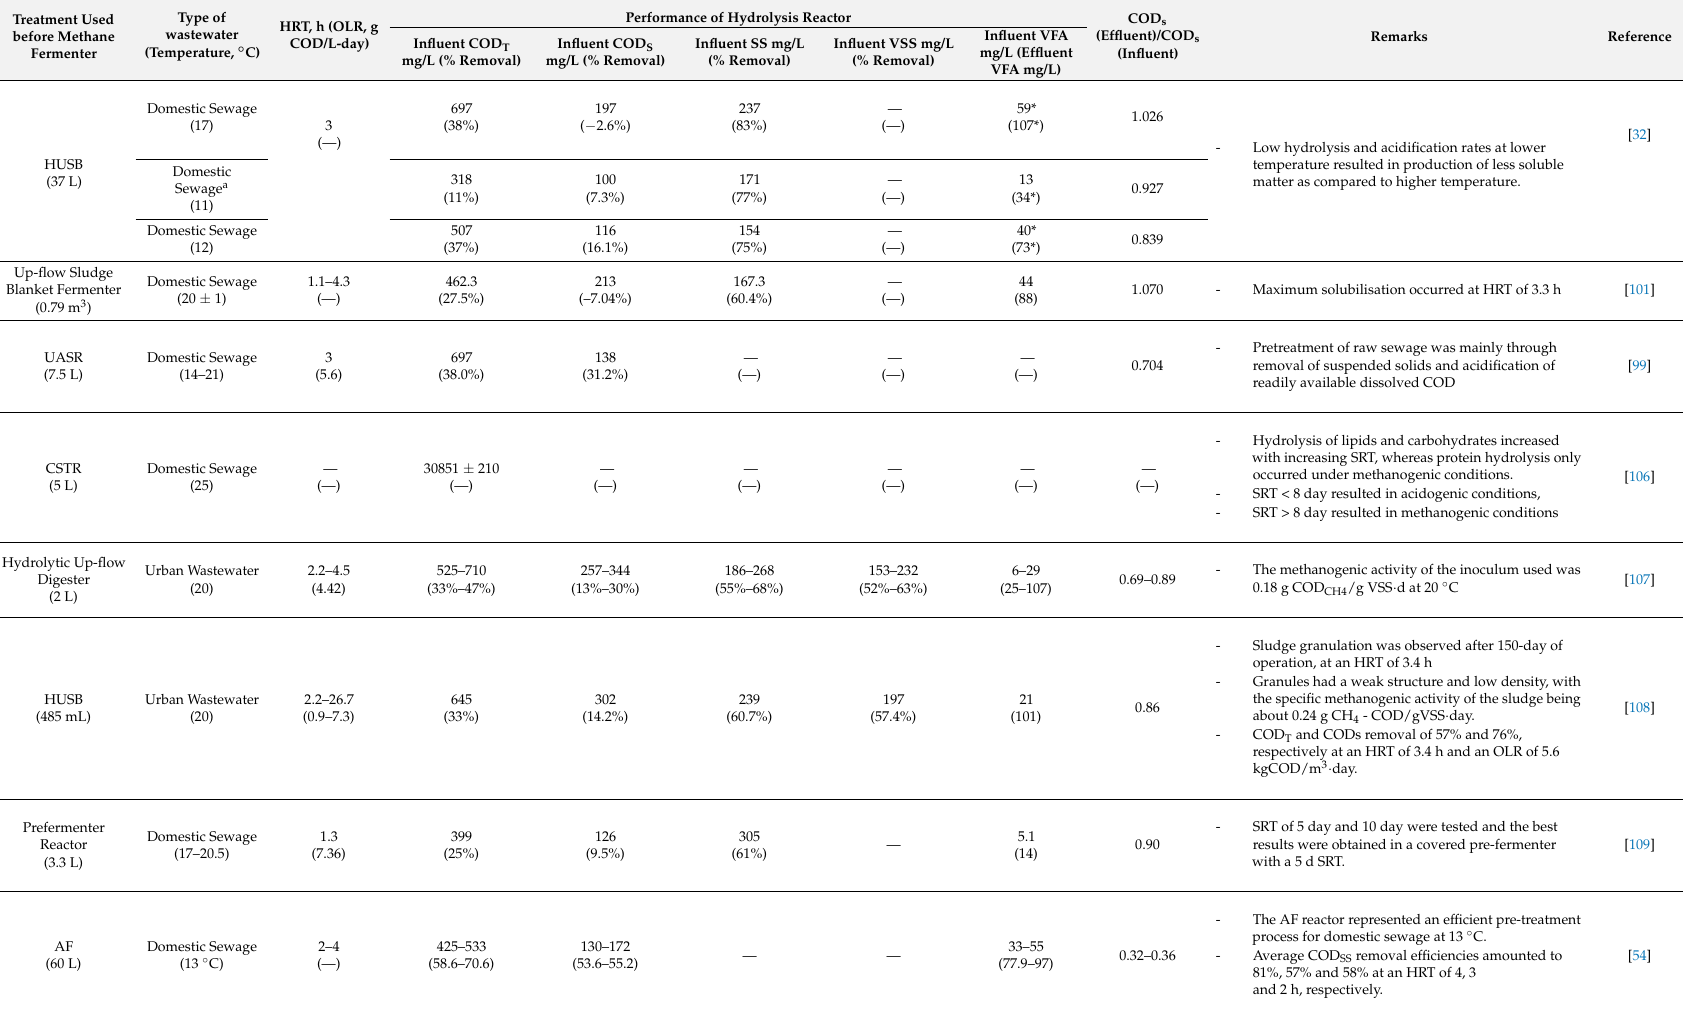
Table 4. Hydrolysis performance on bench-scale and pilot-scale solubilization reactors for the treatment of domestic wastewater. PerformanceofHydrolysisReactorTreatmentUsed beforeMethane